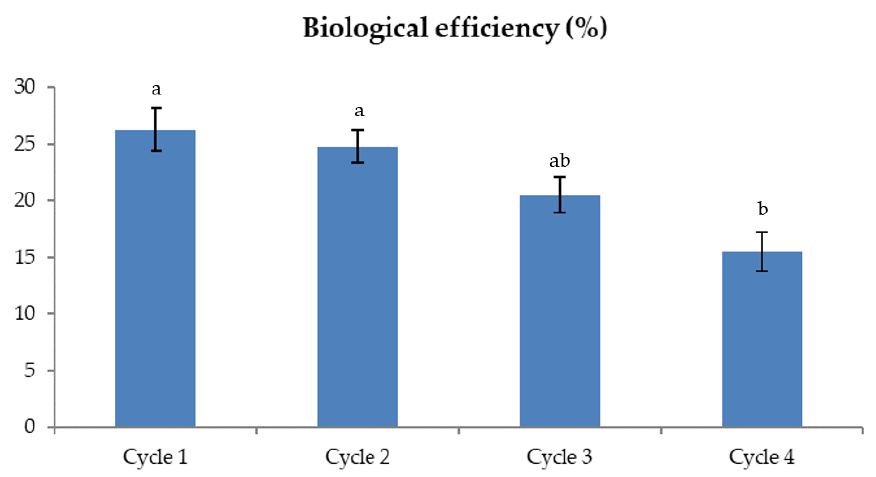
Figure 2. Biological efficiency % of each production cycle. Different letters indicate significant differences among cycles ( p < 0.05).